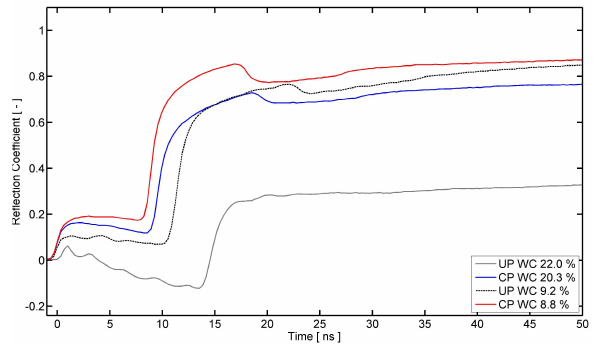
Fig. 4: Reflectograms obtained with coated (CP) and uncoated (UP) SUSU03 probes with 2 Fig. 4. Reflectograms obtained with coated (CP) and uncoated (UP) 0.60 m rods at two different soil moistures, measured in an experimental box with glass beads 3 SUSU03 probes with 0.60m rods at two different soil moistures, (Table 2). Bulk electrical conductivity was 1.0 10 -2 dS m -1 for the dry case and 6.7 10 -2 dS m -1 4 measured in an experimental box with glass beads (Table 2). Bulk for the wet case. 5 electrical conductivity was 1.0 × 10 − 2 dSm − 1 for the dry case and 6.7 × 10 − 2 dSm − 1 for the wet